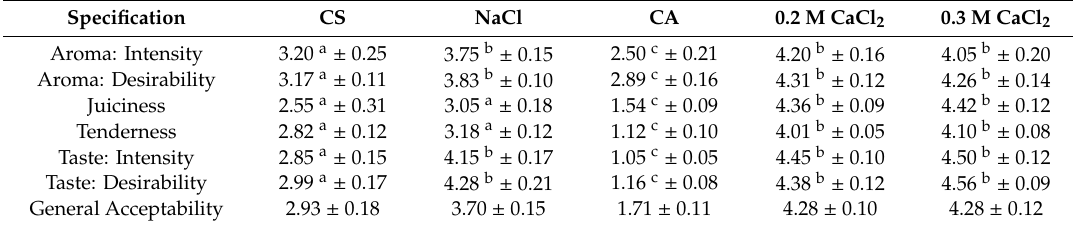
Table 5. Sensory properties of horse meat during cold storage ( x ±